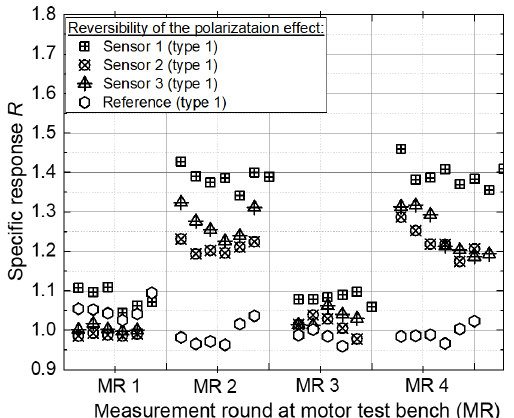
Figure 5. Specific responses of three sensors (1–3) operated in al- ternation by the regular (MR1 and MR3) and prepolarization (MR2 and MR4) strategy in four measurements in a row. A reference sen- sor monitors equal experimental conditions. Each point represents 1 value of R evaluated from one sensor cycle. The values of R are scaled to the mean specific response of the reference sensor. The experiment was carried out at the Daimler OM646 test